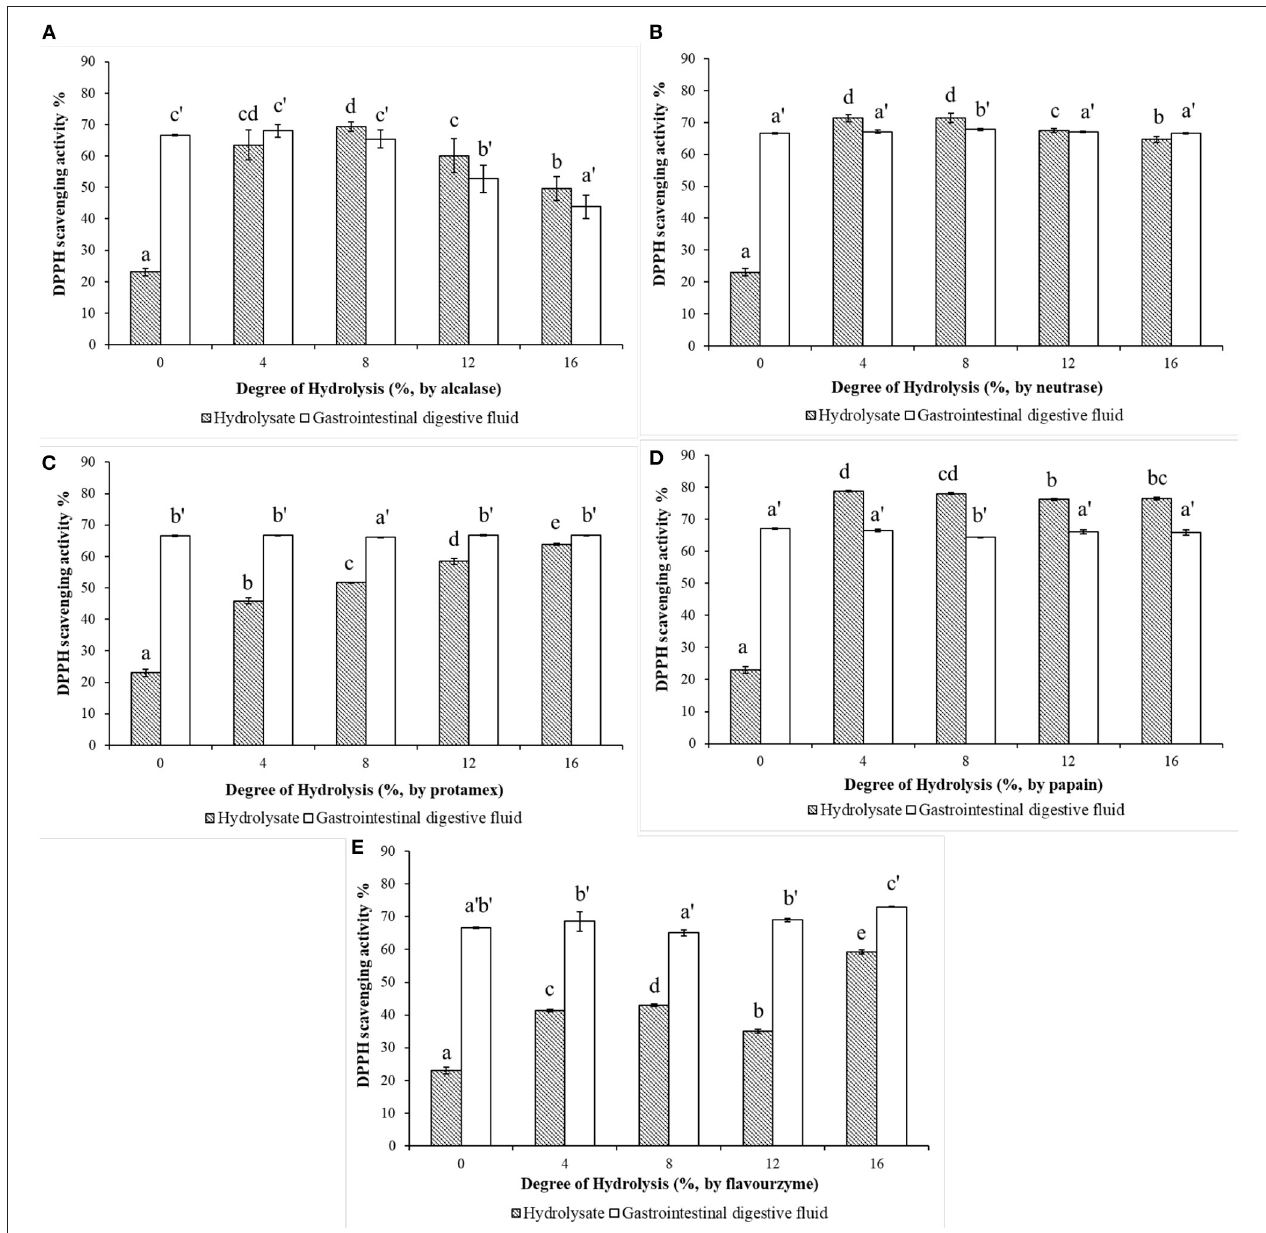
FIGURE 3 | Effects of the degree of hydrolysis (DH) of in vitro limited enzymolysis on the DPPH radical-scavenging activity of walnut protein hydrolysates before and after the simulated gastrointestinal digestion in vitro . (A) Walnut protein hydrolysate produced by alcalase; (B) Walnut protein hydrolysate produced by neutrase; (C) Walnut protein hydrolysate produced by protamex; (D) Walnut protein hydrolysate produced by papain; (E) Walnut protein hydrolysate produced by flavourzyme. The results are expressed as mean ± SD ( n = 3). Means with different superscripts are significantly different ( p <